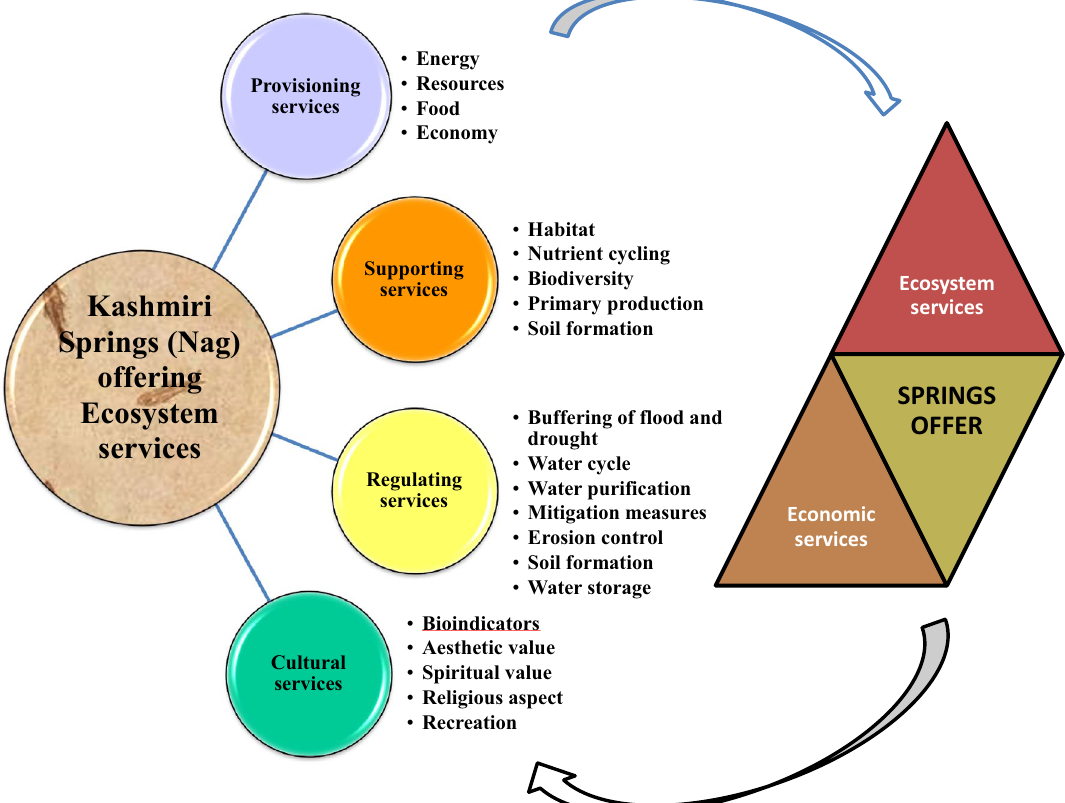
Fig. 9 Listing of various ecosystem services offered by Kashmir Himalayan Springs